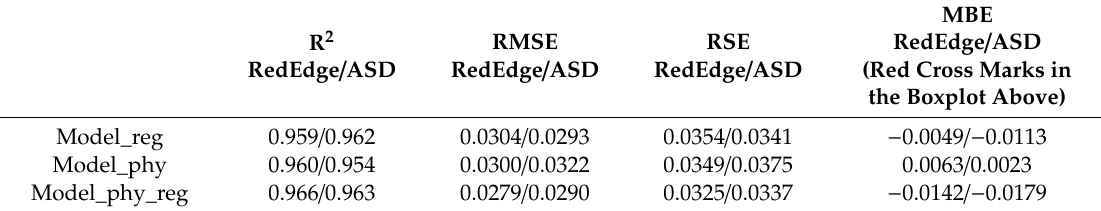
Figure 10. Validation results of the three models estimated from RedEdge images- and ASD measurement-based narrowband albedos. Table 7. Validation results with measures of R 2 , RMSE, RSE, and